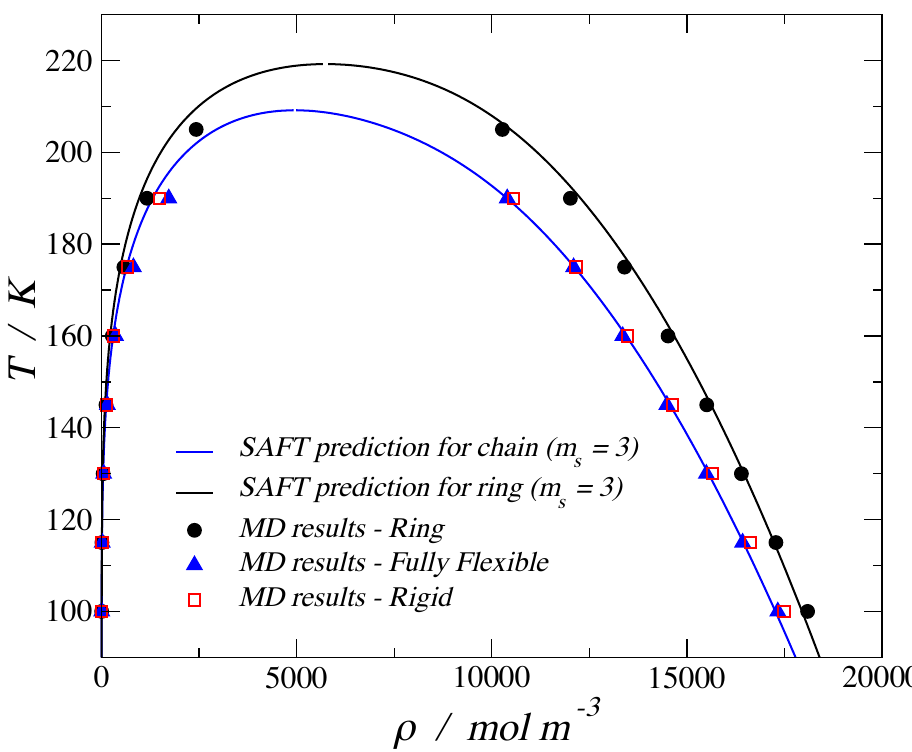
Figure 1. Temperature–density vapor–liquid coexistence curve for a 3-bead Lennard-Jones fluid. The solid blue line corresponds to the SAFT-VR-Mie equation of state (EoS) for chains, the solid black line corresponds to the SAFT-VR Mie EoS for rings [24], the filled black circles are obtained by molecular dynamic (MD) simulations for the ring trimer, the filled blue triangles are the simulation results for a fully flexible trimer, and the empty red squares are the simulation results for a rigid (stiff) linear